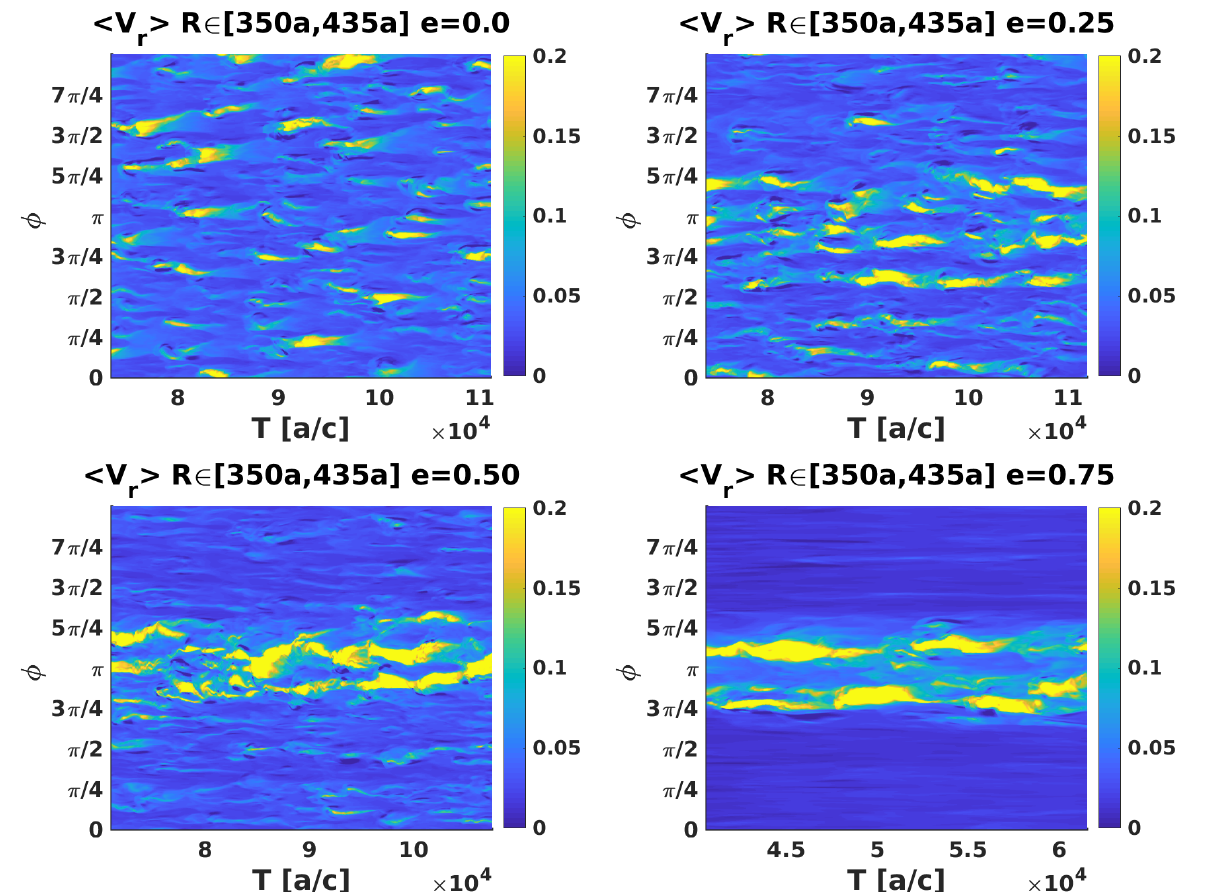
Figure 11. Map of v r , averaged over R in the interval [ 350 a ,435 a ] , in the φ ( y -axis) versus T ( x -axis) plane, at R = 400 a , for different eccentricities: e = 0 ( left-top panel ); e = 0.25 ( right-top panel ); e = 0.5 ( left-bottom panel ); and e = 0.75 ( right-bottom panel